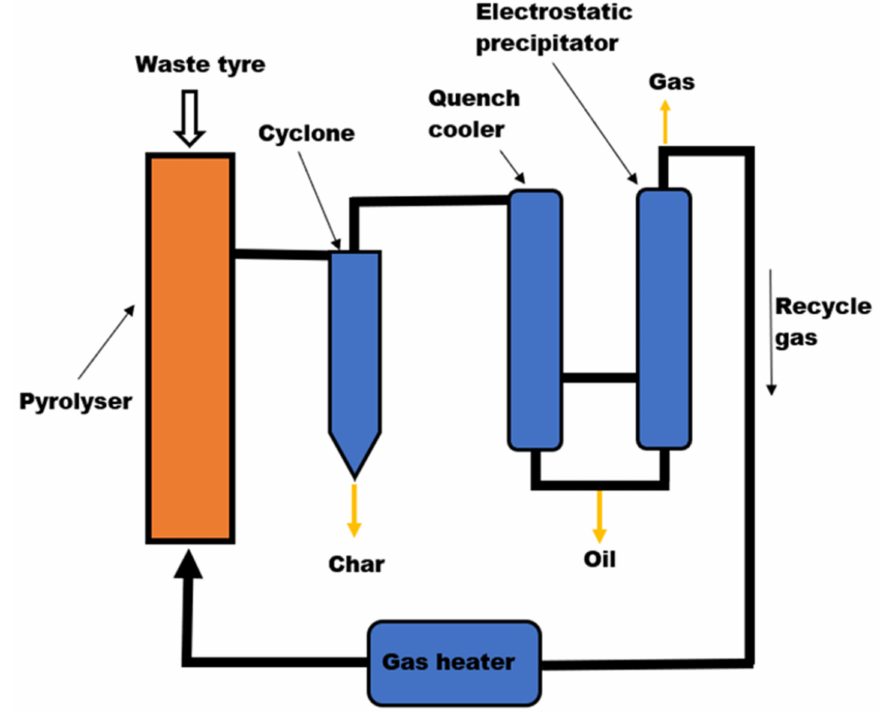
Figure 5. Diagram of a fluidised bed pyrolysis